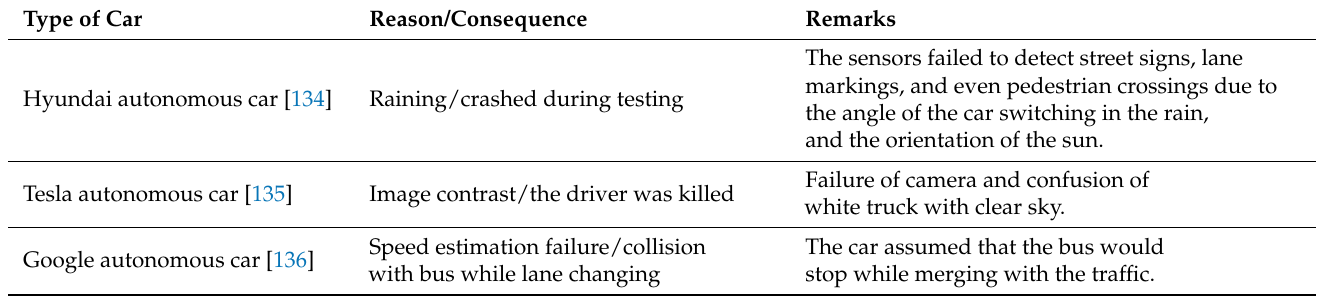
Table 9. Various accidents during the development of autonomous vehicle (AV)